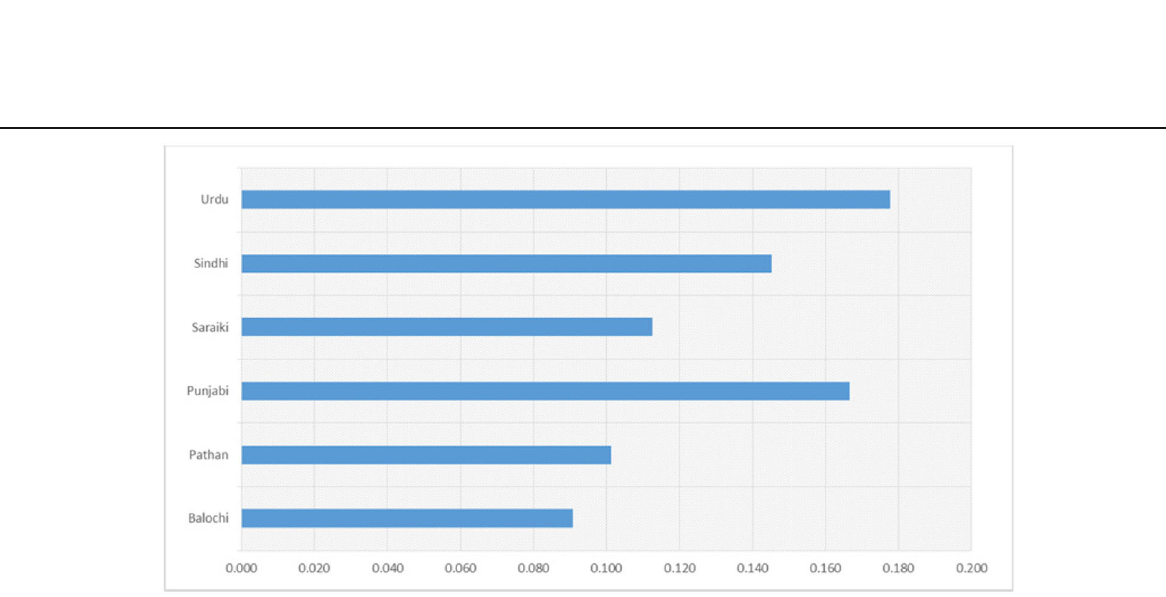
Fig. 3 H63D variant allele frequency for principal ethnicities in our patient